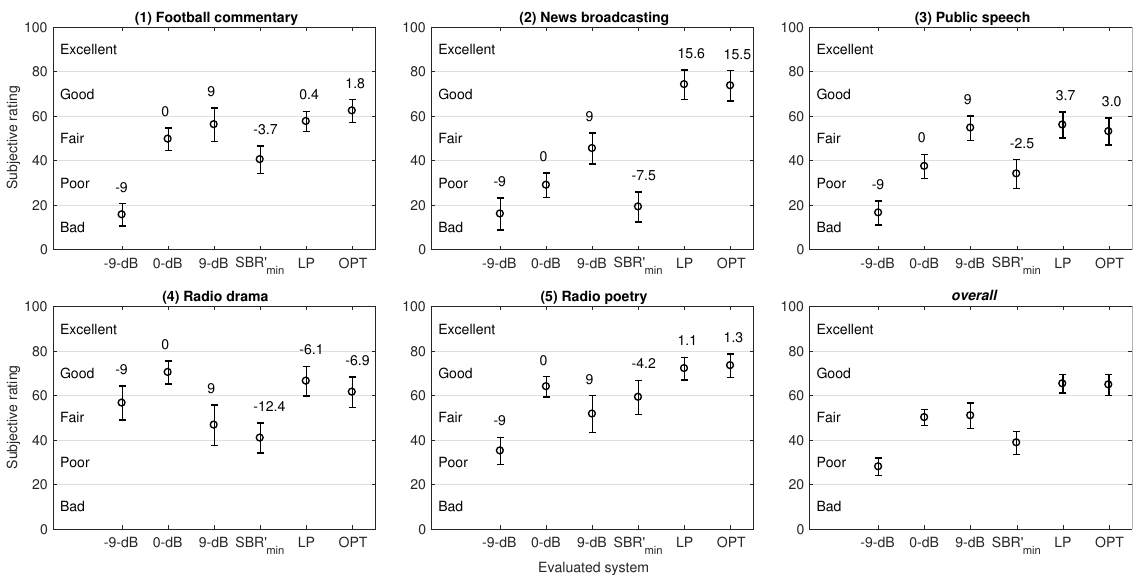
Figure 7. Subjective rating for listening experience with various mix levels (shown above each data point in dB) in the five audio scenes (panel 1–5). The ‘ overall ’ panel shows the rating over all the scenes. Error bar indicates 95% confidence interval of the